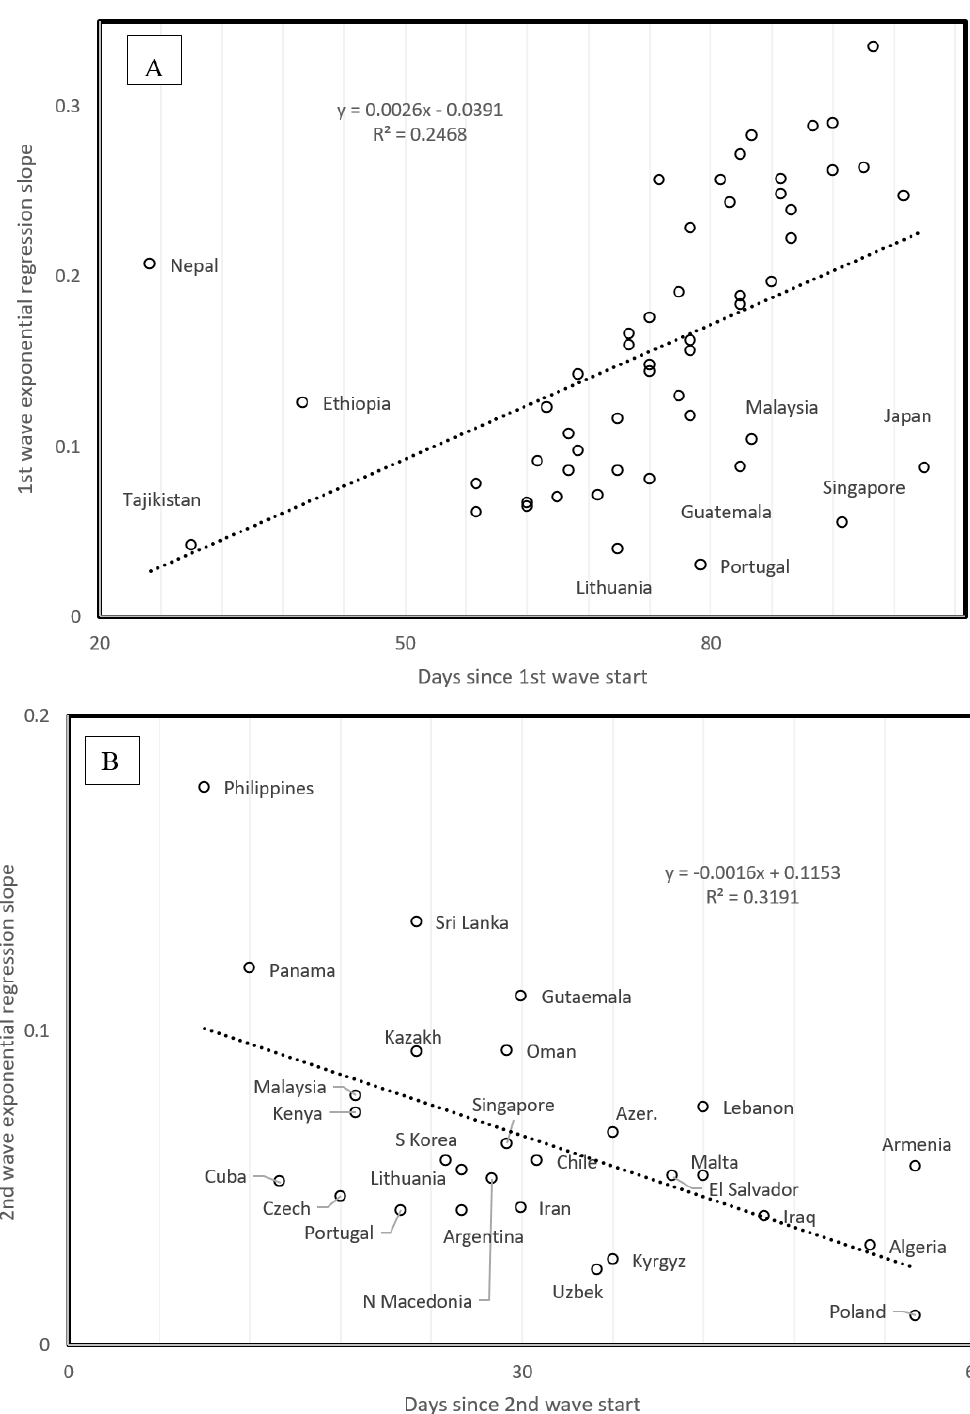
Figure 5. Slope of daily increase in confirmed COVID-19 cases as a function of time since wave started for ( A ) first wave and ( B ) second wave.